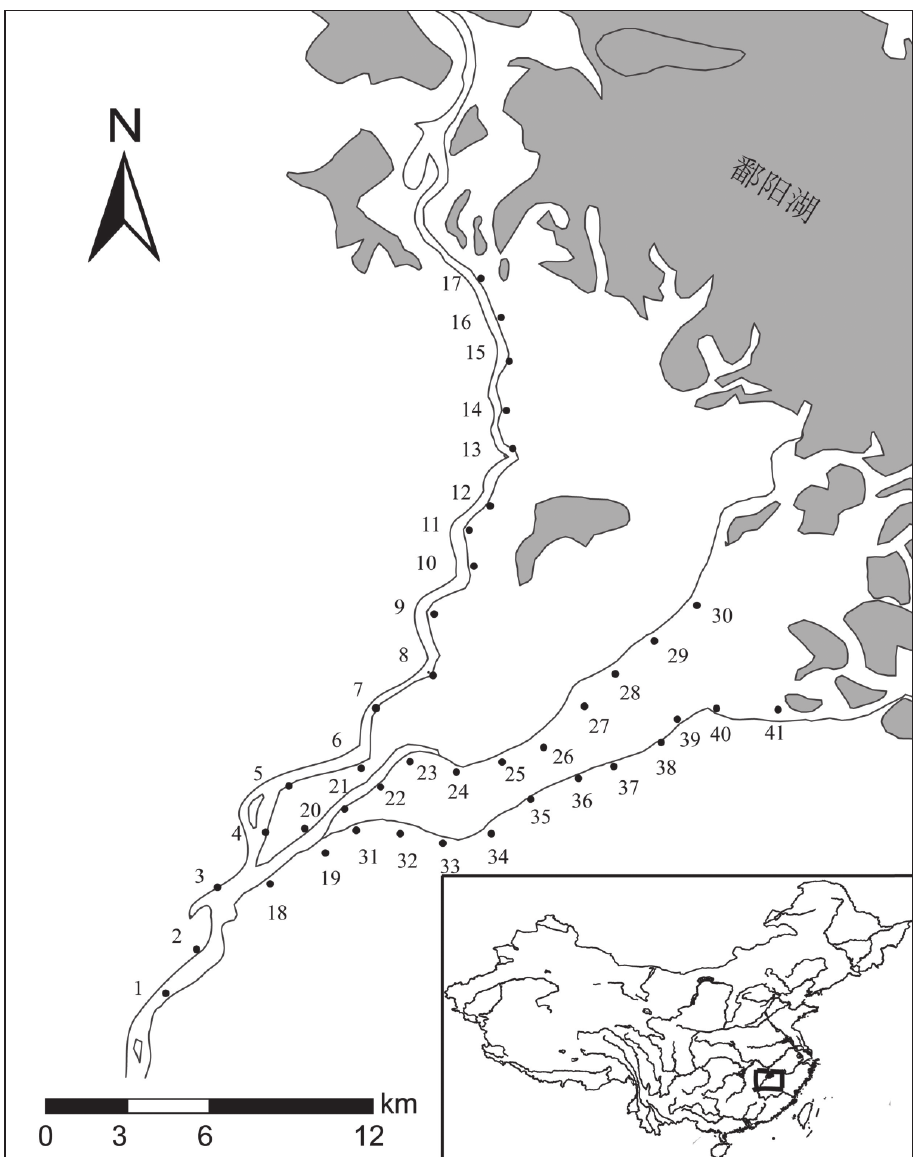
Figure 1. Sampling map of S.